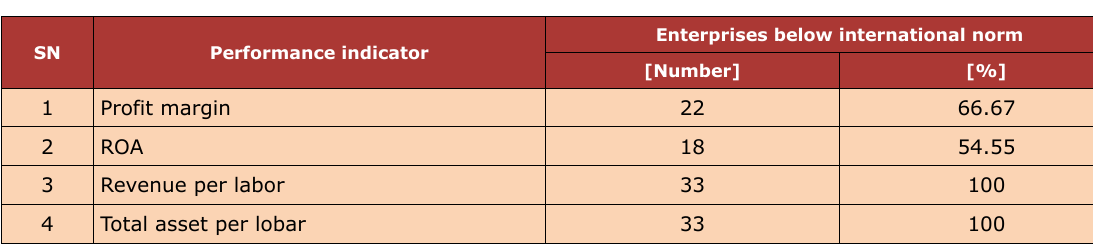
Table 7. Number of enterprises below world average